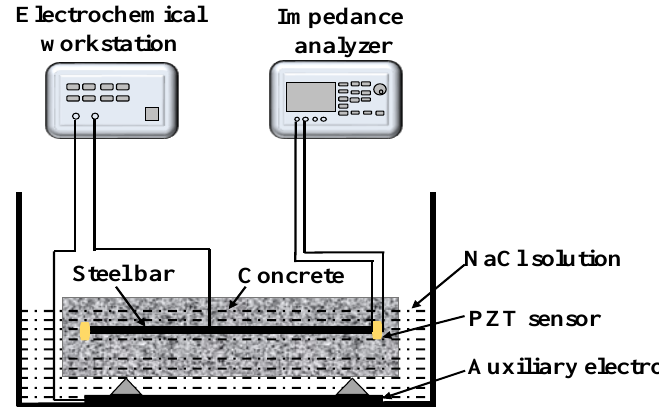
Figure 3. Schematic diagram of corrosion monitoring of reinforced concrete.